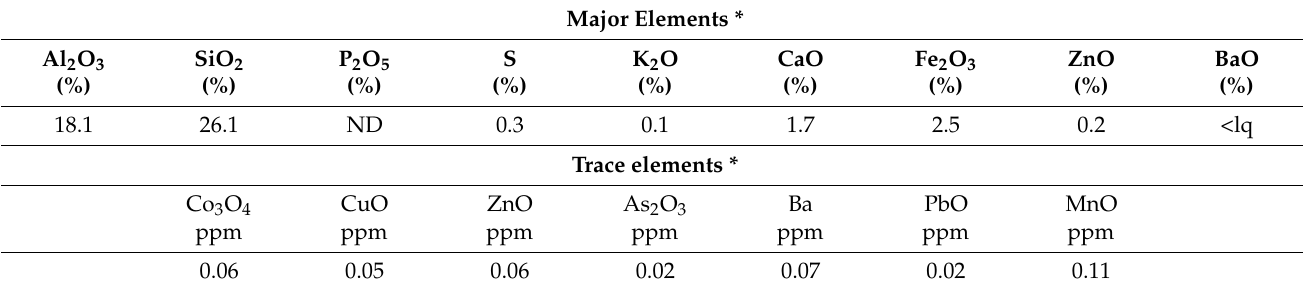
Table 4. Chemical composition of the synthesized ZA5 and modified zeolite ZA-Li + . Major Elements